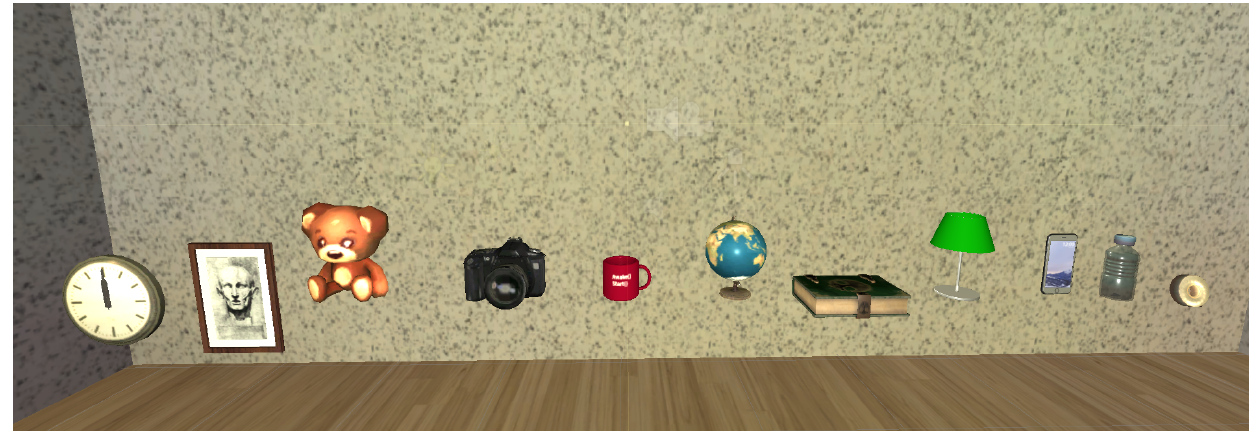
Figure 3. Demo A example with objects that will be randomly arranged in the room.